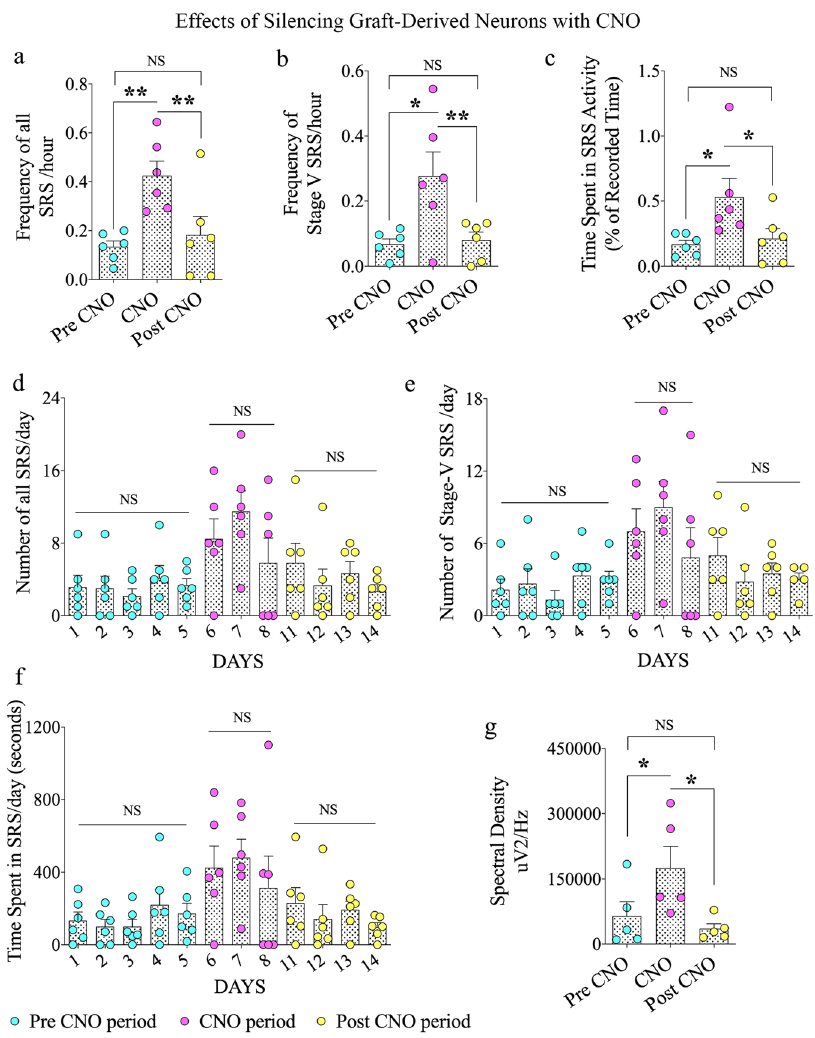
Fig. 3 Effects of silencing graft-derived neurons with clozapine-N-oxide (CNO) on spontaneous recurrent seizure (SRS) activity in chronically epileptic rats. The bar charts a – c compare all SRS and stage V SRS frequencies and times spent in SRS activity (% of recorded time) during pre-CNO, CNO, and post-CNO periods. The bar charts d – f compare all SRS and stage V SRS frequencies and times spent in SRS activity during the pre-CNO (days 1 – 5), CNO (days 6 – 8), and post-CNO (days 11 – 14) periods. The bar chart g compares the average electroencephalographic (EEG) power (i.e., spectral density) recorded in interictal periods during pre-CNO, CNO, and post-CNO phases. Values in bar charts are presented as mean ± S.E.M. * p < 0.05; ** p < 0.01; NS, non-signi fi cant (one-way ANOVA with Newman – Keuls multiple comparisons